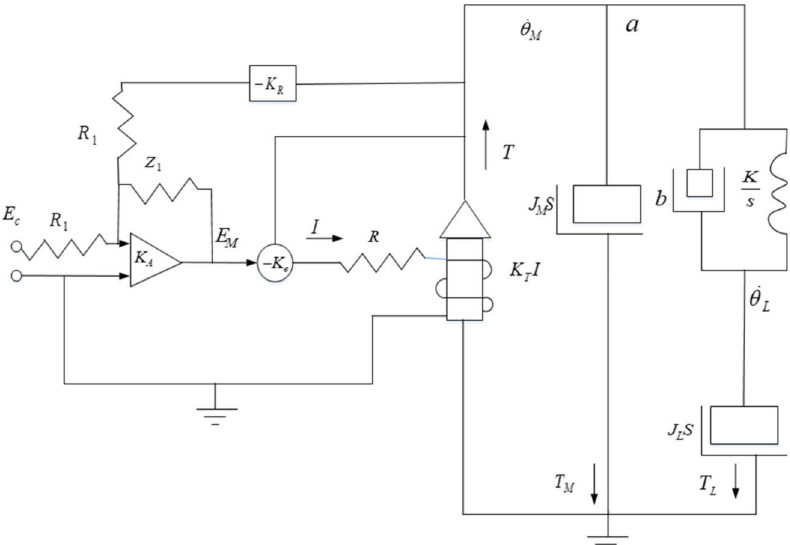
Figure 3. Simplified system of aviation photoelectric stabilization